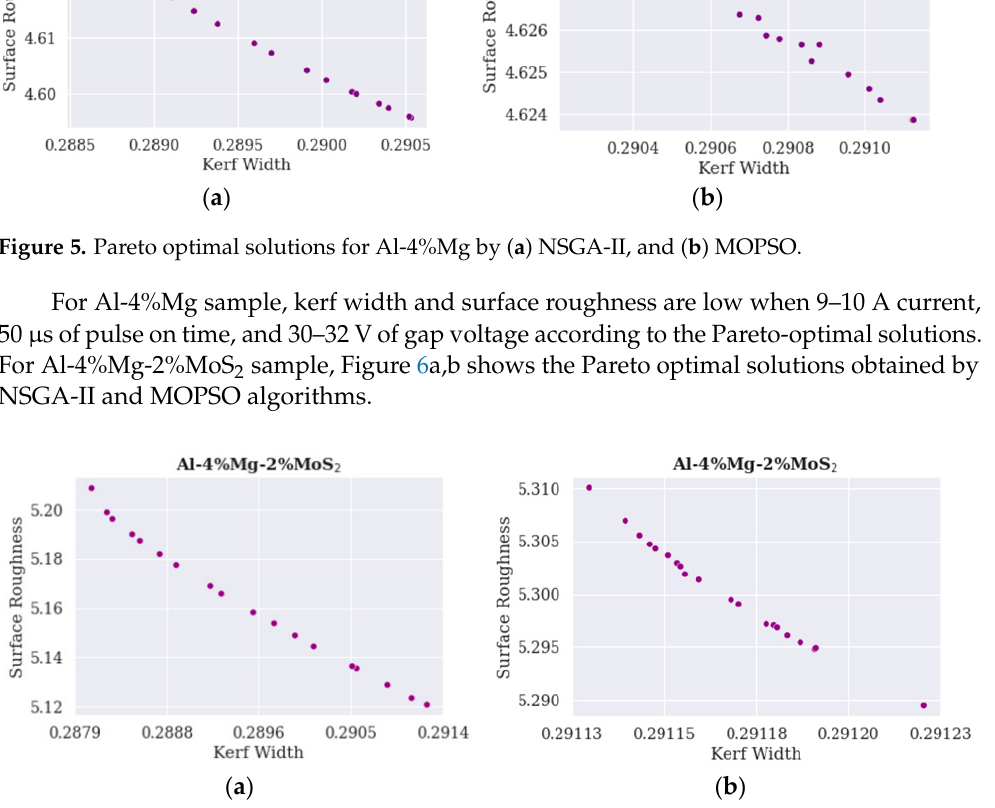
Figure 4. Pareto optimal solutions of Pure Al by ( a ) NSGA-II and ( b ) MOPSO. Pareto optimal solutions obtained show that kerf width and surface roughness of pure Al is low for a current of 9 A and gap on a voltage of 33 V. With these conditions, when pulse on time is increased, kerf width increases and surface roughness decreases. For Al-4%Mg sample, Figure 5a,b shows the Pareto optimal solutions obtained by NSGA-II and MOPSO.